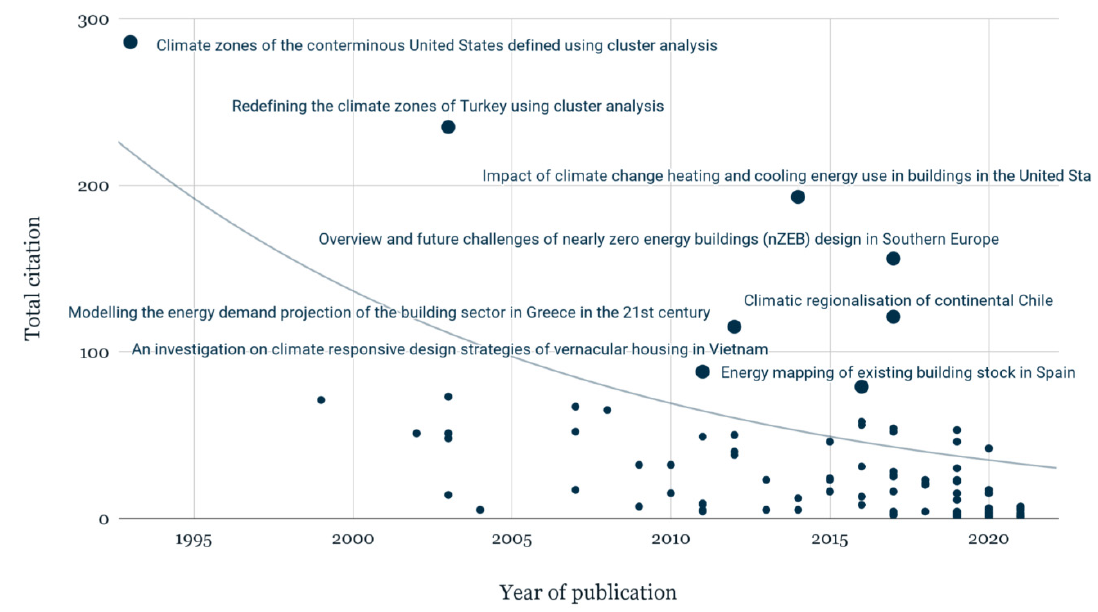
Figure 16. The ratio of citations to the year of publication and papers cited above trend.